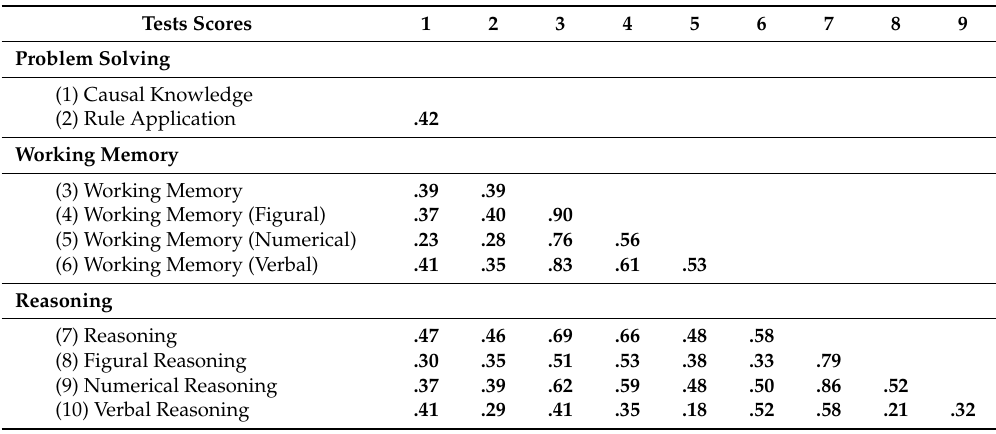
Table 1. Correlations between problem solving, working memory, and reasoning. Significant correlations are marked in bold typefaces ( α = .05).